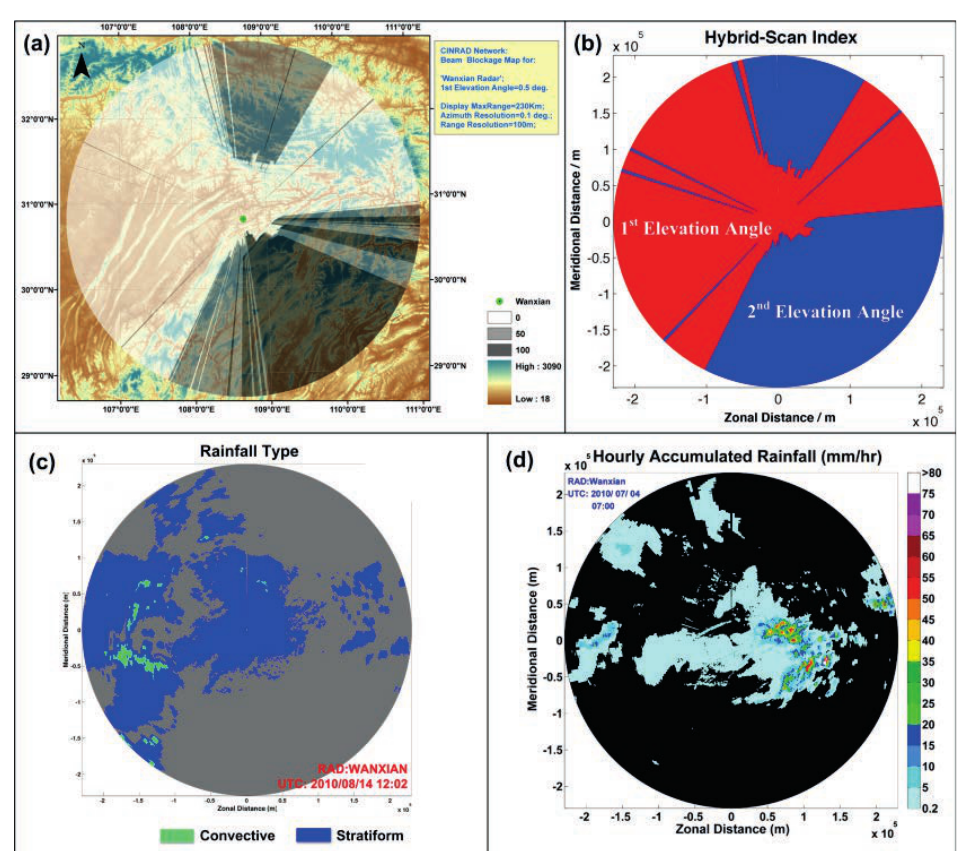
Fig. 2 Major procedures of radar QPE algorithms at the Three Gorges